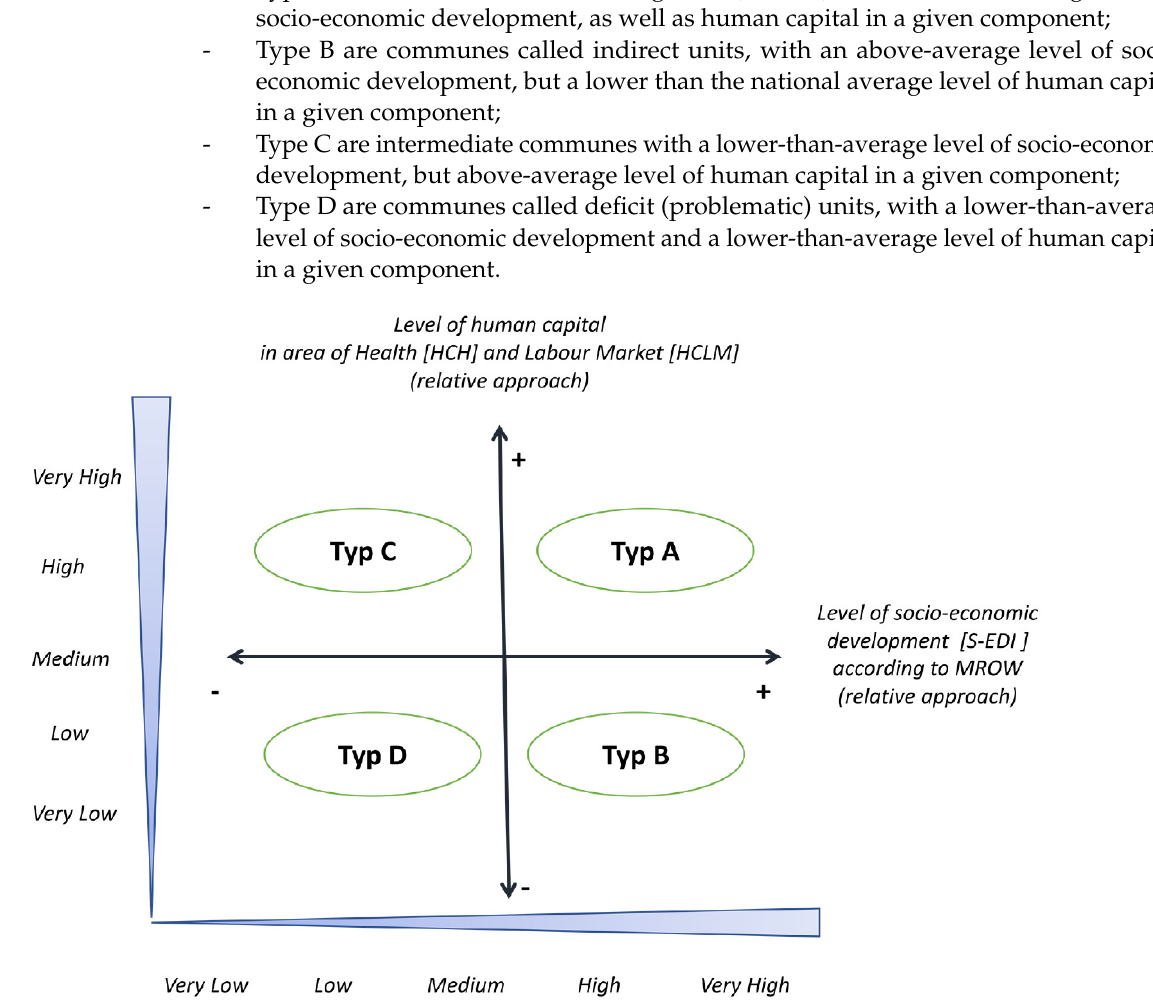
Table 5. HCH and HCLM—basic characteristics for communes in each class in terms of level of human capital.